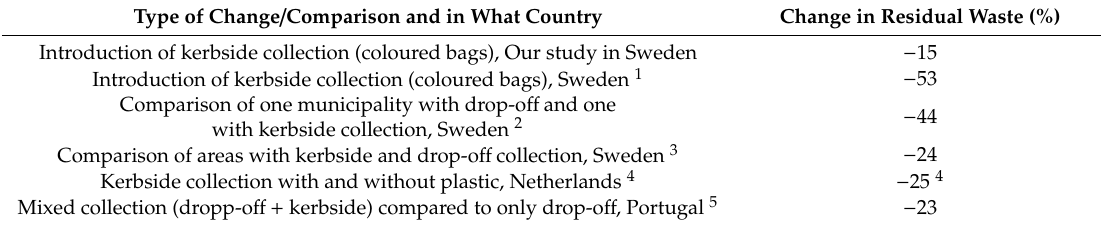
Table 3. Change in residual waste (%) in di ff erent studies and regions after (1) the introduction of another waste collection system; or (2) comparisons for areas with di ff erent waste collection systems. Type of Change / Comparison and in What Country Change in Residual Waste